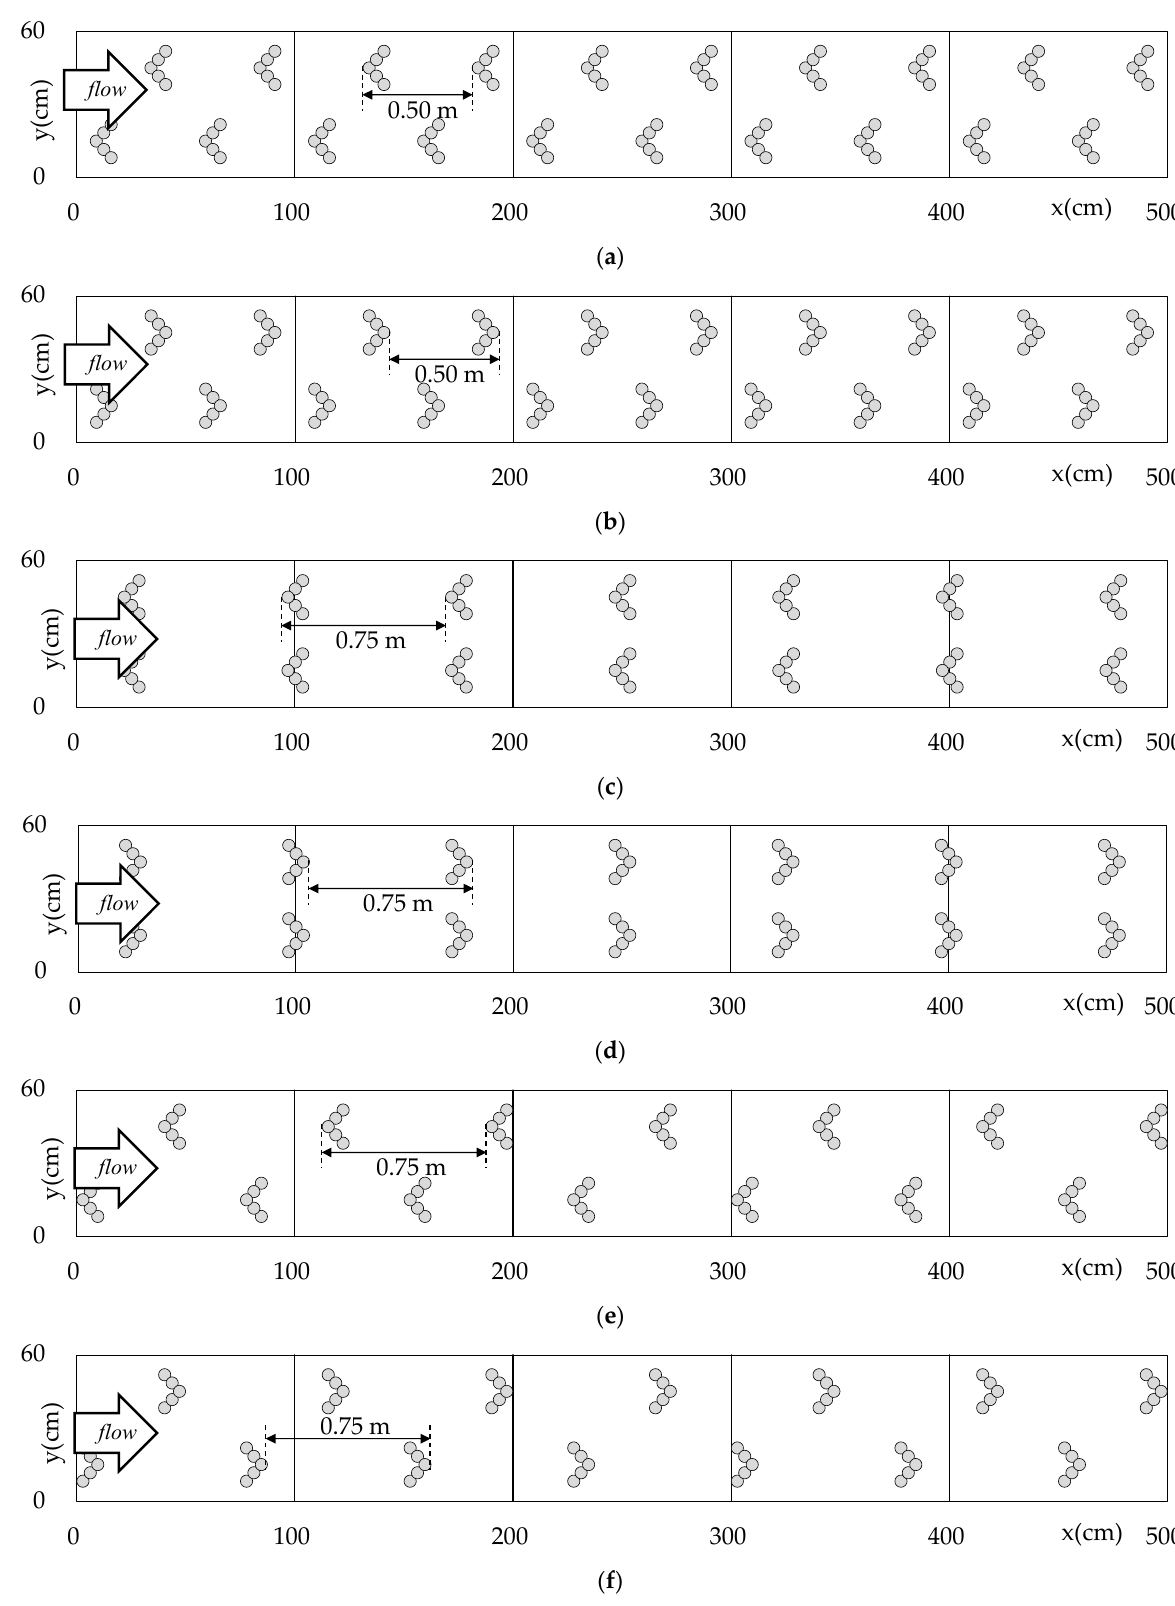
Figure 5. Arrangement of roughness groups in each case of this study: ( a ) Run5-cu in Case 5; ( b ) Run5-cd in Case 5; ( c ) Run6-cu in Case 6; ( d ) Run6-cd in Case 6; ( e ) Run7-cu in Case 7; ( f ) Run7-cd in Case 7.